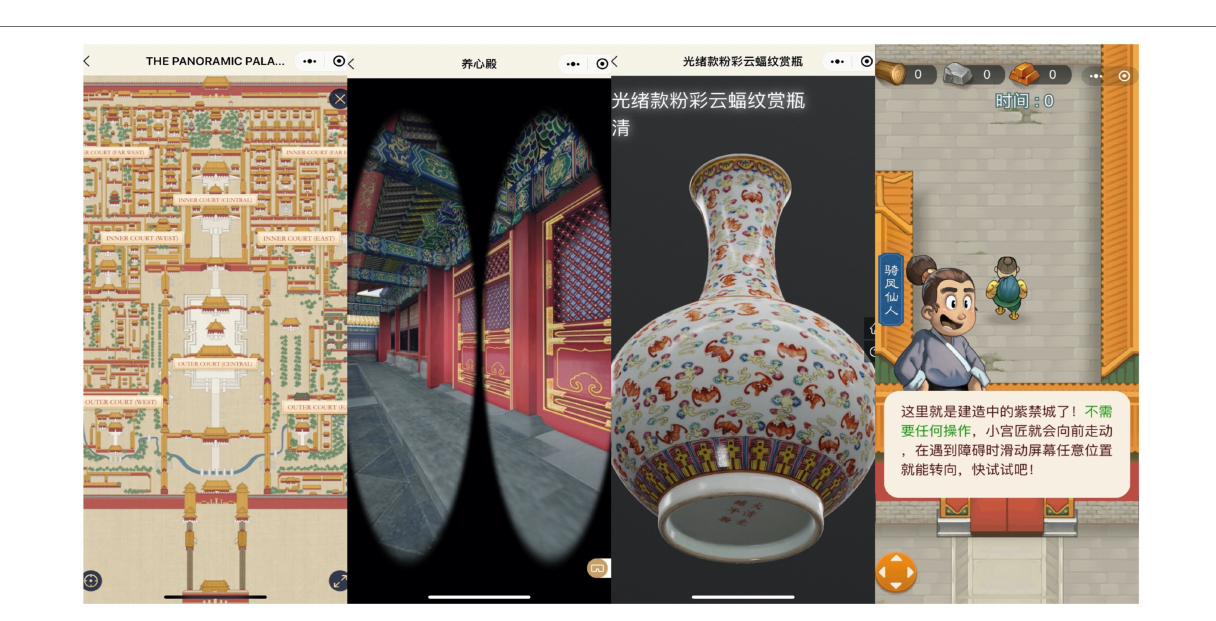
FIGURE 3 | DPM: 3D map, VR tours, digital relics, and virtual tour games (the texts above the vase show the name of the vase and the dynasty of Qing, the cartoon character says: This is the Forbidden City under construction! Without any operation, the craftsman will move forward. When encountering obstacles, you can swipe the screen to make him turn. Try